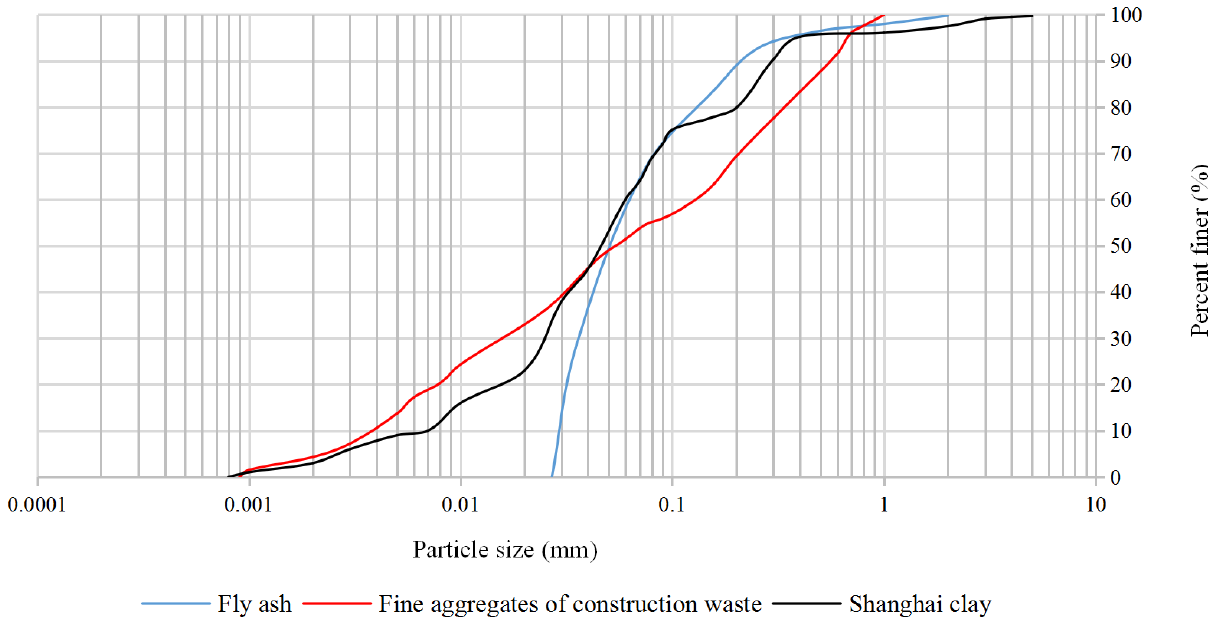
Figure 2: Particle size distribution of Shanghai clayey soil, fine aggregates of construction waste and fly ash. Table 1: Physical and water-physical properties of Shanghai clayey soil.